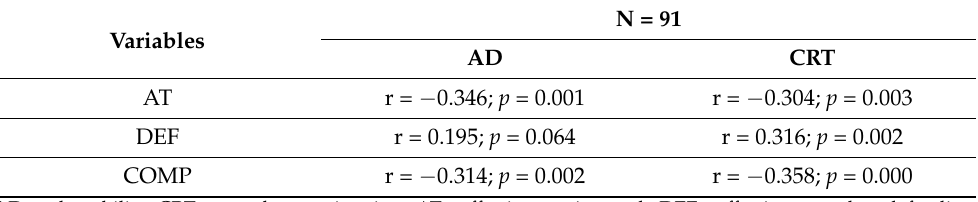
Table 1. Relationships between the levels of the studied coordination motor skills and the indicators of the assessment of an individual player’s effectiveness in football—Pearson’s r correlation coefficients. N = 91 Variables AD CRT AT r = − 0.346; p = 0.001 r = − 0.304; p = 0.003 DEF r = 0.195; p = 0.064 r = 0.316; p = 0.002 COMP r = − 0.314; p = 0.002 r = − 0.358; p = 0.000